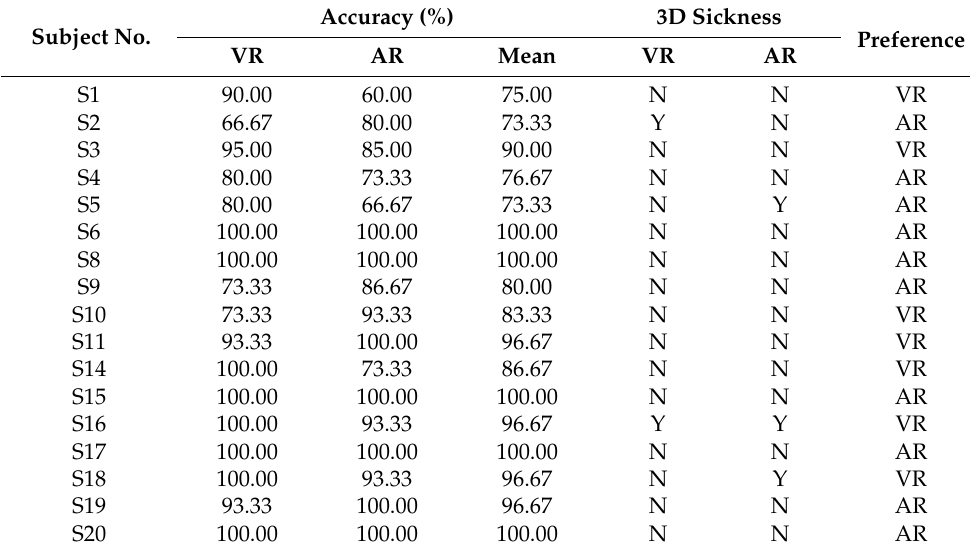
Table 3. Results of the